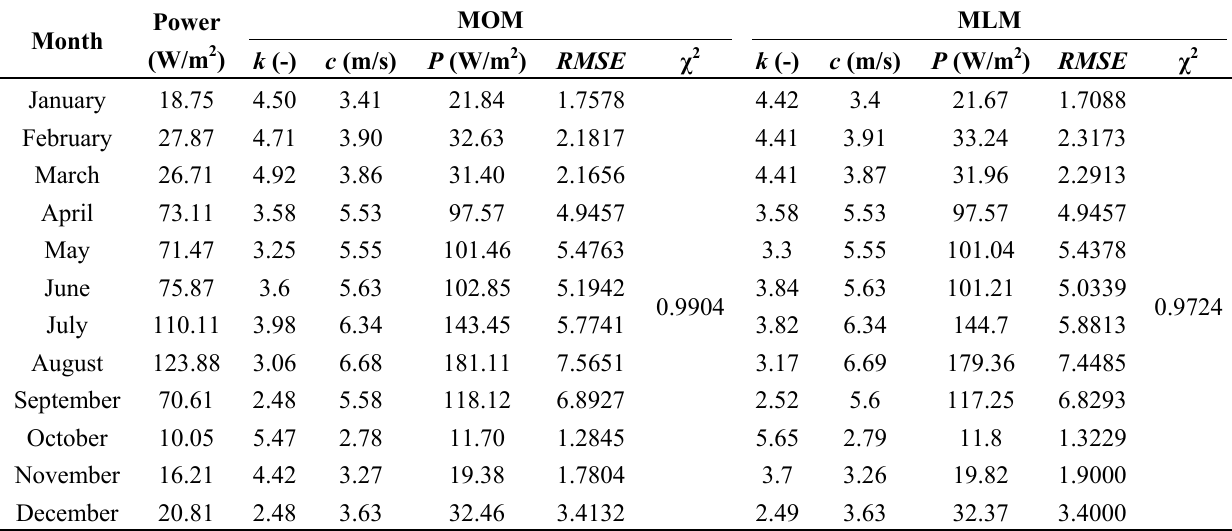
Table 12. Monthly mean power based on measured data and calculated data by statistical methods.